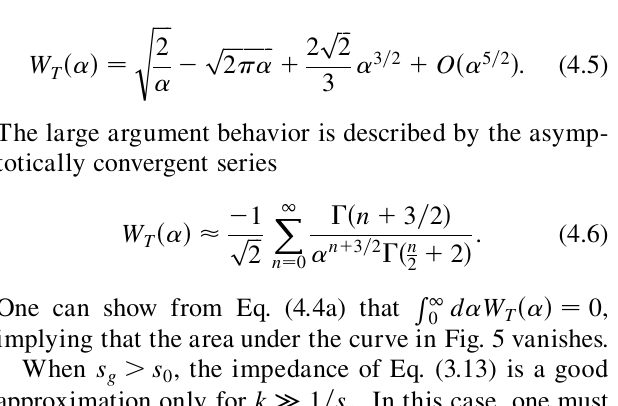
appearing in Eq. (4.3). T